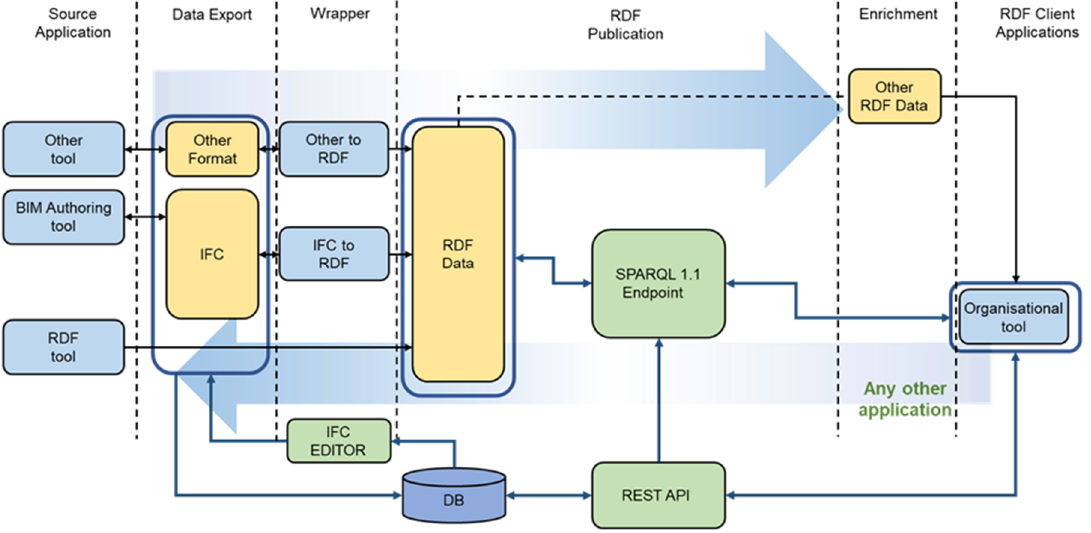
Figure 3. Approach of the proposed BIM Management System.